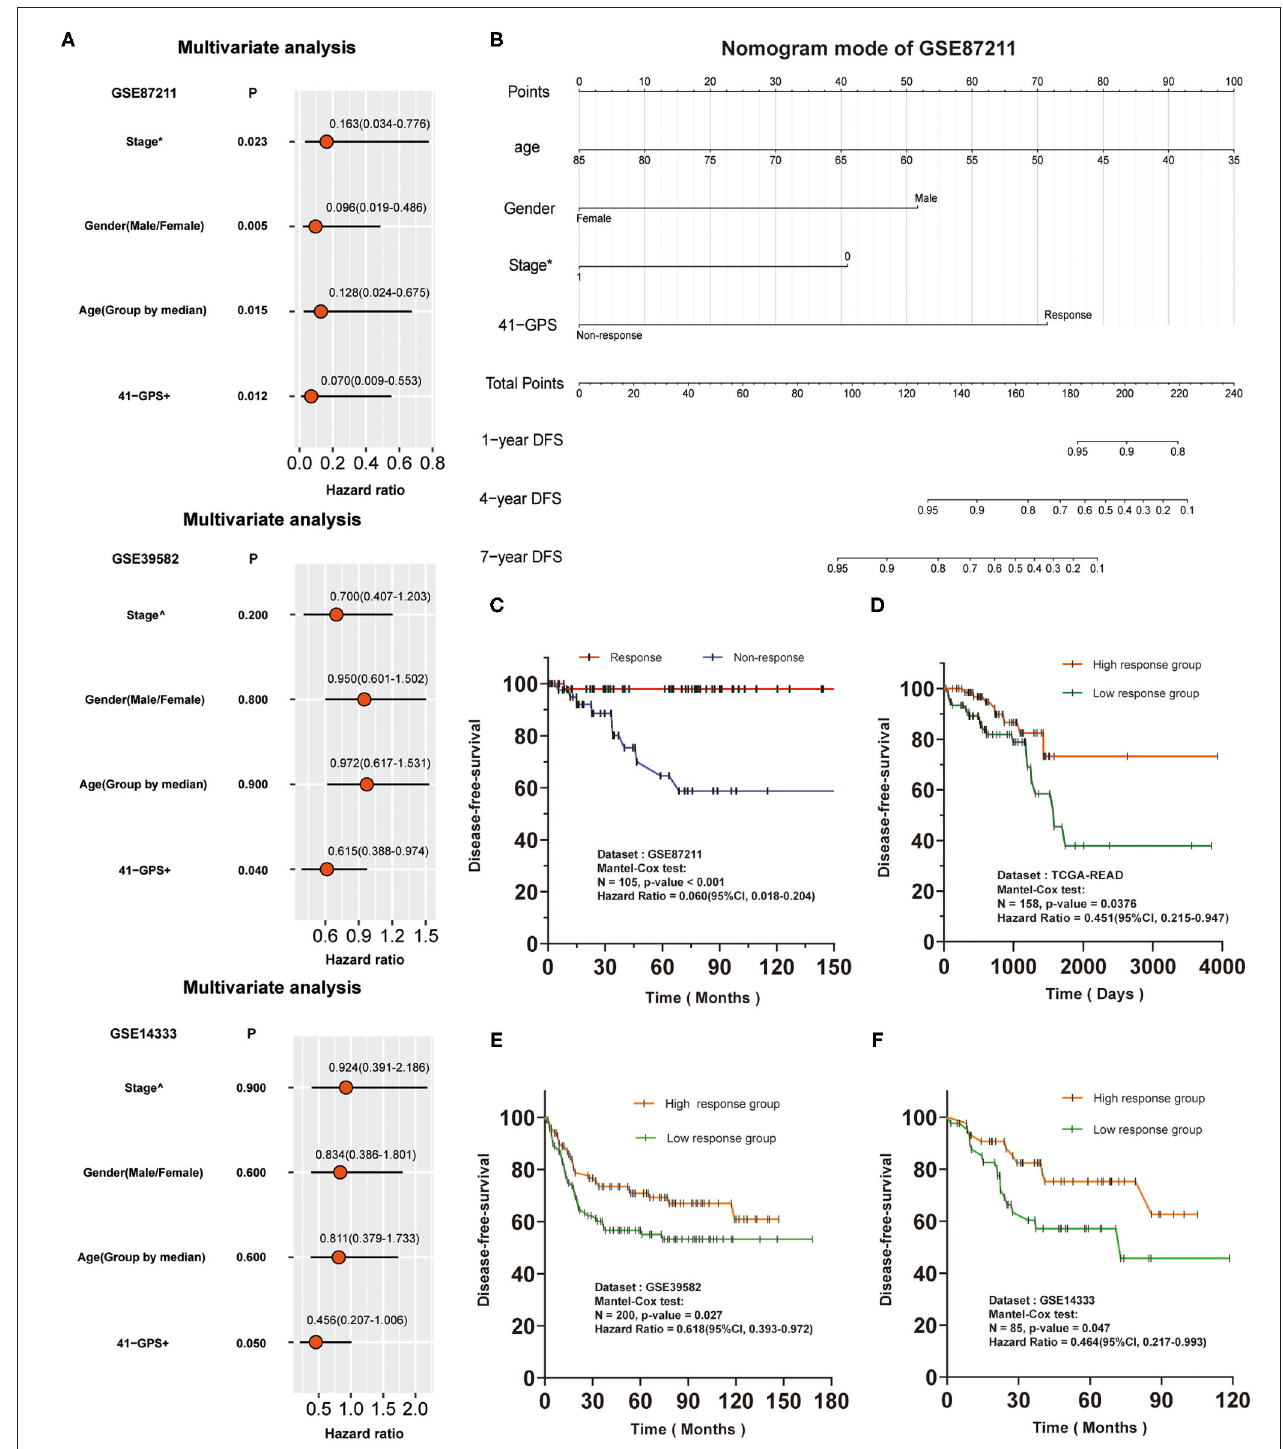
FIGURE 5 | Independence verification and survival analysis verification of 41-GPS. Stage*: The status of lymph node metastasis before surgery, 0 means no metastasis, 1 means metastasis. Stage ∧ : The stage of colon cancer. 41-GPS + : In multivariate analysis of GSE87211, patients were divided into responders and non-responders. In multivariate analysis of GSE39582 and GSE14333, patients were divided into high-response groups and low-response groups according to the number of responding gene pairs. (A) Univariate analysis of GSE87211, GSE39582 and GSE14333. Hazard ratio and P -values were calculated using log-rank test. (B) Nomogram models of GSE87211. (C) Disease-free survival rate of 105 locally advanced rectal cancer patients in GSE87211. (D) Disease-free survival rate of 156 rectal cancer patients in TCGA-READ. (E) Disease-free survival rate of 200 colorectal cancer patients in GSE39582. (F) Disease-free survival rate of 85 colorectal cancer patients in